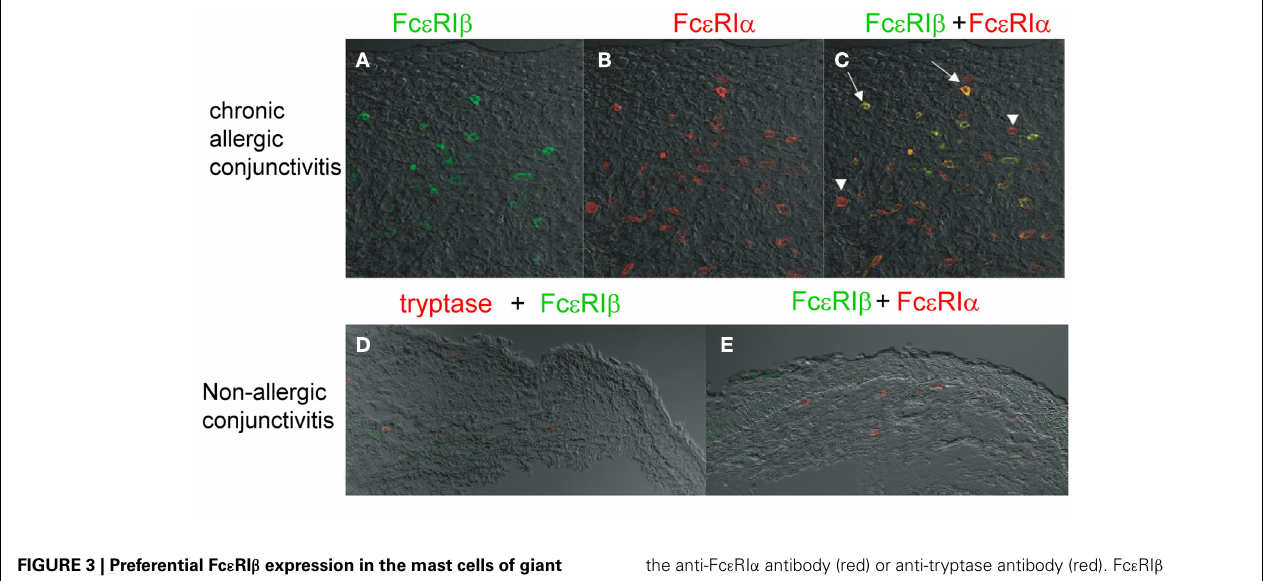
FIGURE 3 | Preferential Fc ε RI β expression in the mast cells of giant papillae from patients with atopic keratoconjunctivitis. Anti-Fc ε RI β antibody immunostaining of giant papillae. Immunohistochemical staining was carried out with giant papillae specimens obtained from patients with AKC orVKC (A–C) and from patients with superior limbic keratoconjunctivitis (D,E) using the anti-Fc ε RI β antibody (green) and